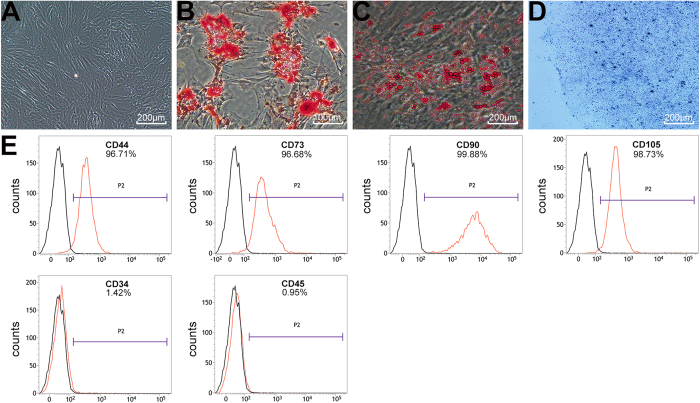
Tri-lineage differentiation potentials and flow cytometry analysis of BMMSCs.(A) Homogeneous distributions were observed on BMMSCs of P3. (B) Osteogenesis was examined using alizarin red staining. (C) Adipogenic capacity was verified using oil red O staining. (D) Chondrogenic potential was assessed by toluidine blue staining. (E) The results of flow cytometry showed that BMMSCs of P3 had a specific phenotype.